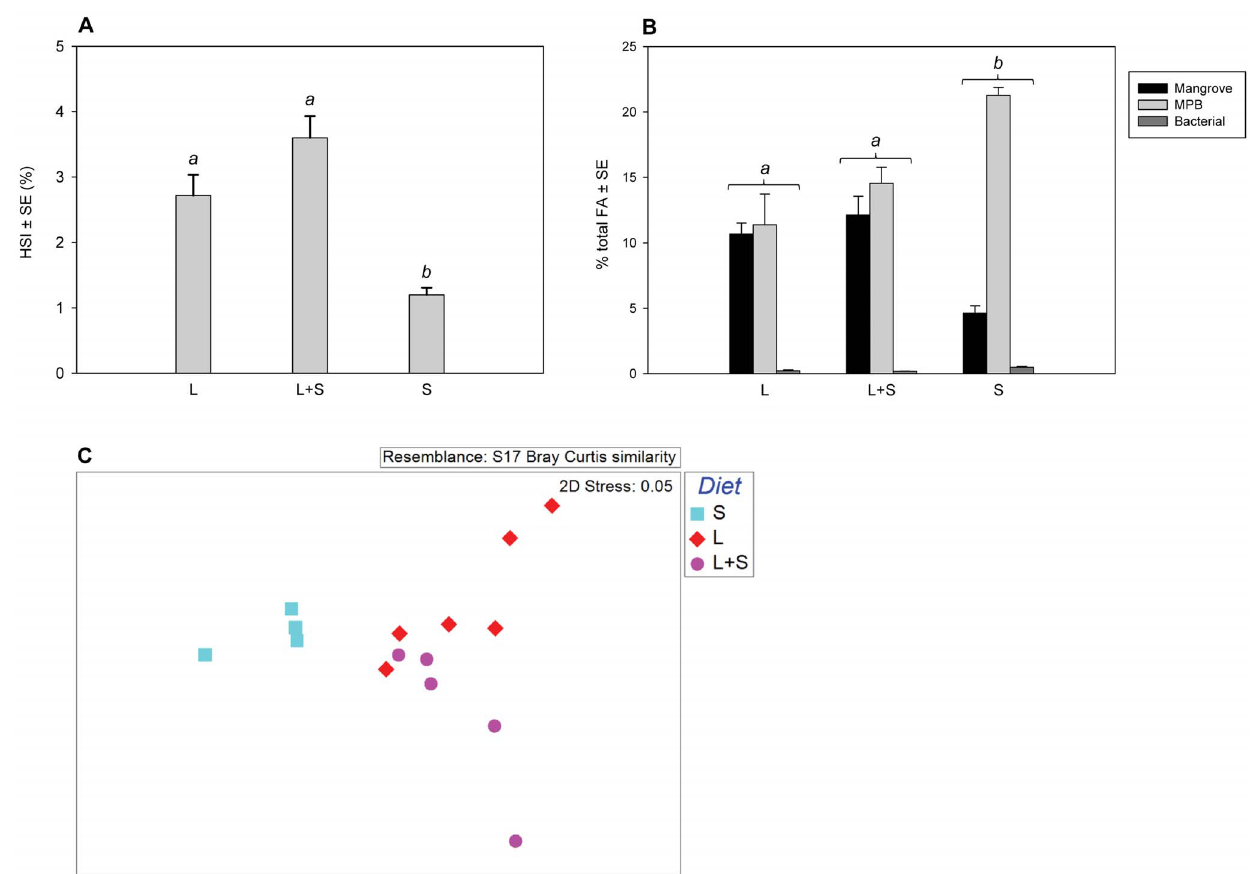
Figure 1. Influence of available organic matter on the fitness of P.erythodactyla . Crabs were offered mangrove leaves only (L, n=6), mangrove leaves and sediment (L + S, n=5) or sediment only (S, n=4) for 63 days. Means HSI (A) and % to total FA in muscle tissue of FA biomarkers of the mangrove leaf litter, bacteria and MPB (B) were compared by one-way ANOVA or Kruskal-Wallis H non-parametric tests. Means marked with different letters are significantly different (Tukey’s HSD or Mann-Whitney U, p , 0.05). Similarity of FA profiles of crabs in the three treatments was compared by ANOSIM and graphically presented in a MDS plot (C).